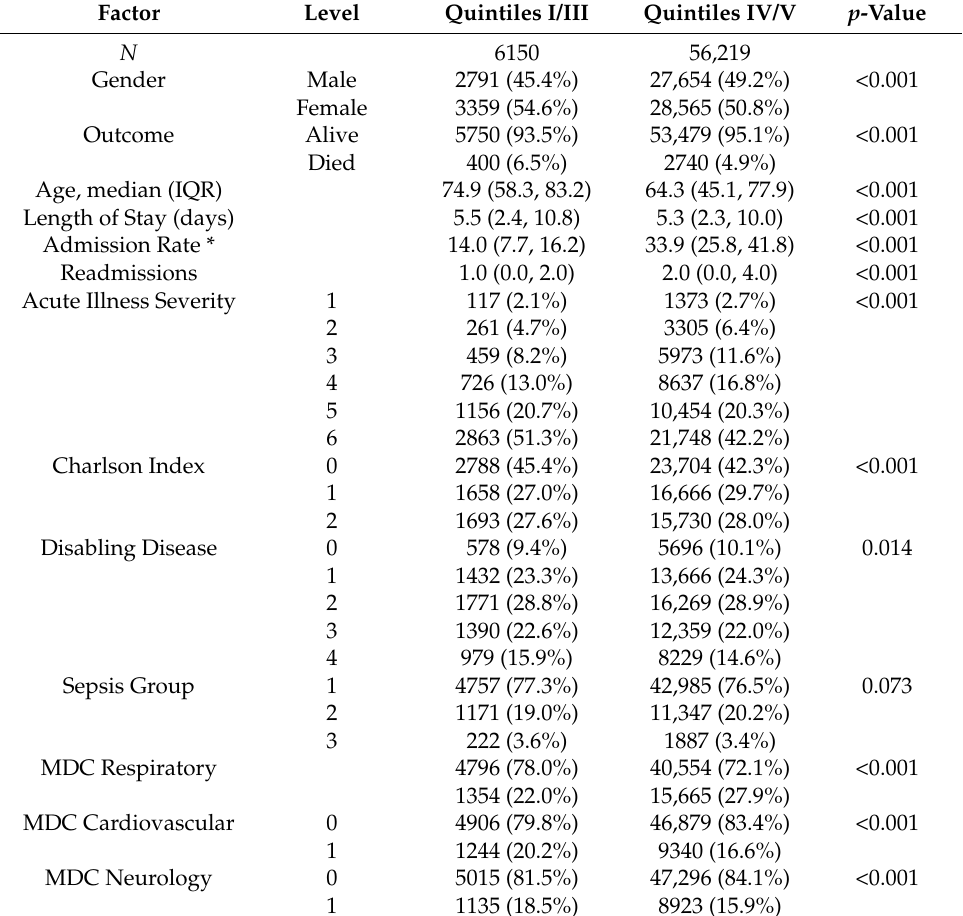
Table 1. Emergency Admissions (2002–2016): Demographics by Deprivation